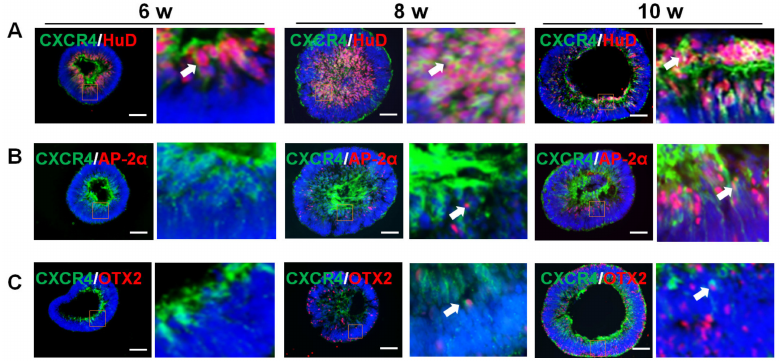
Figure 2. CXCR4 location during various stages of organoid differentiation. ( A ) Most ganglion cells stained with HUD (red) were also stained with CXCR4 (green) at various stages of the differ- entiation of retinal organoids (white arrowhead). ( B ) Few amacrine cells stained for AP-2 α (red) expressed CXCR4 (green) during the differentiation of retinal organoids (white arrowhead). ( C ) Rare photoreceptors stained for OTX2 (red) were stained for CXCR4 (green) during the differentiation of retinal organoids (white arrowhead). Scale bars: 100 µ